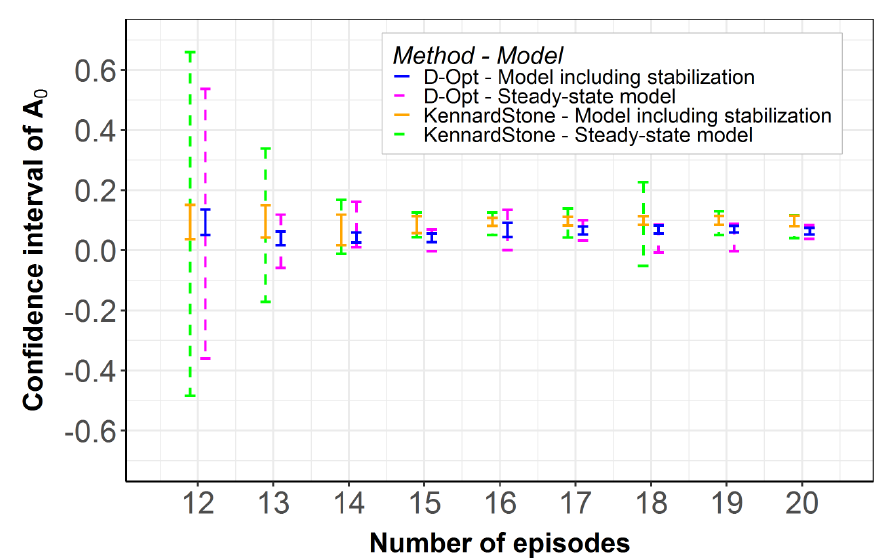
Figure 5. Confidence interval of parameter A 0 as a function of the number of episodes in the calibration database chosen by the D-optimal and Kennard–Stone algorithm.